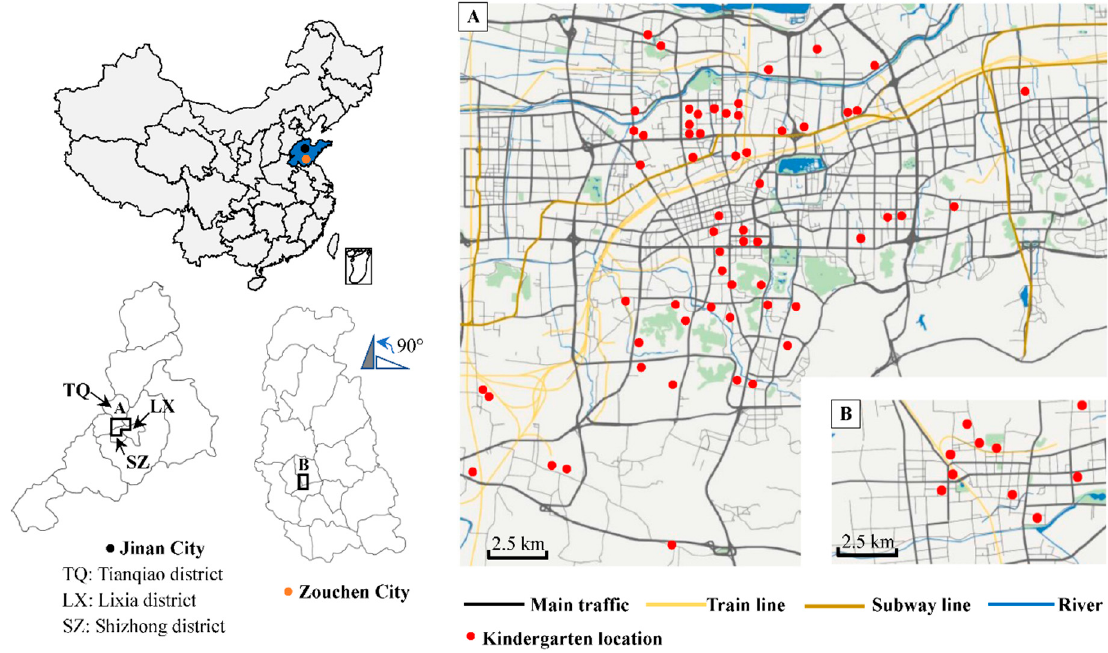
Figure 1. Locations of the surveyed kindergartens. (A): Studied area of Jinan city; (B): Studied area of Zouchen city.